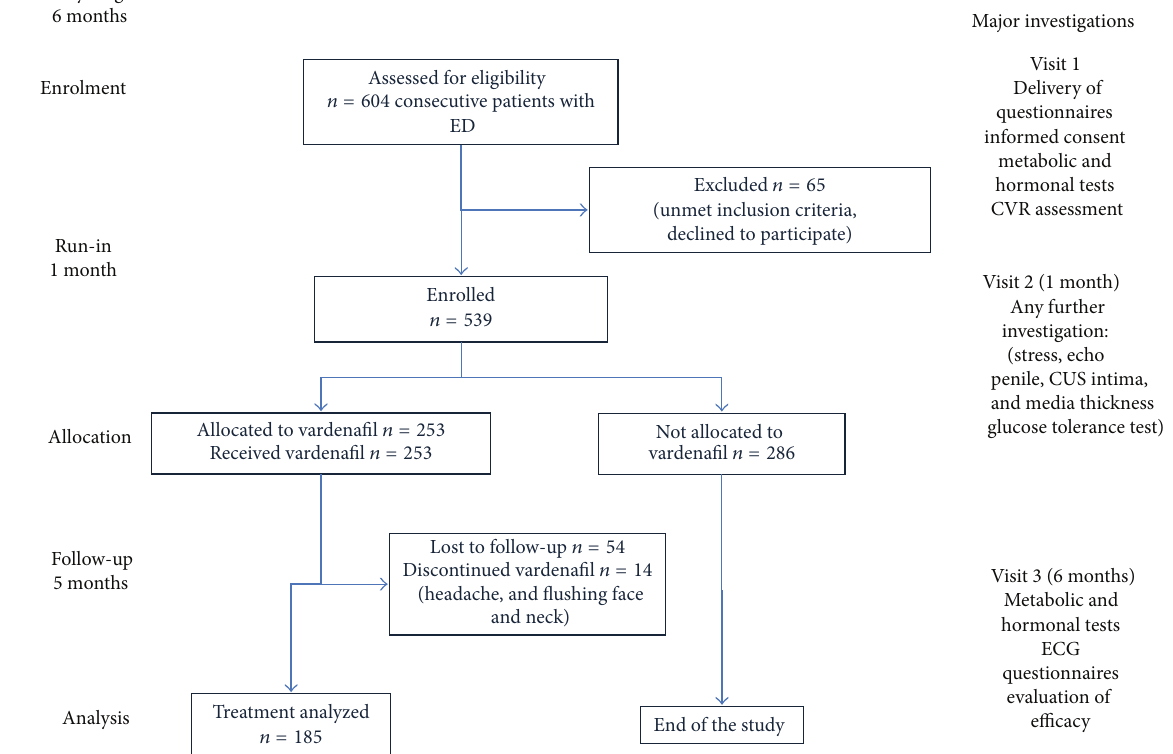
Figure 1: Study design (STARD